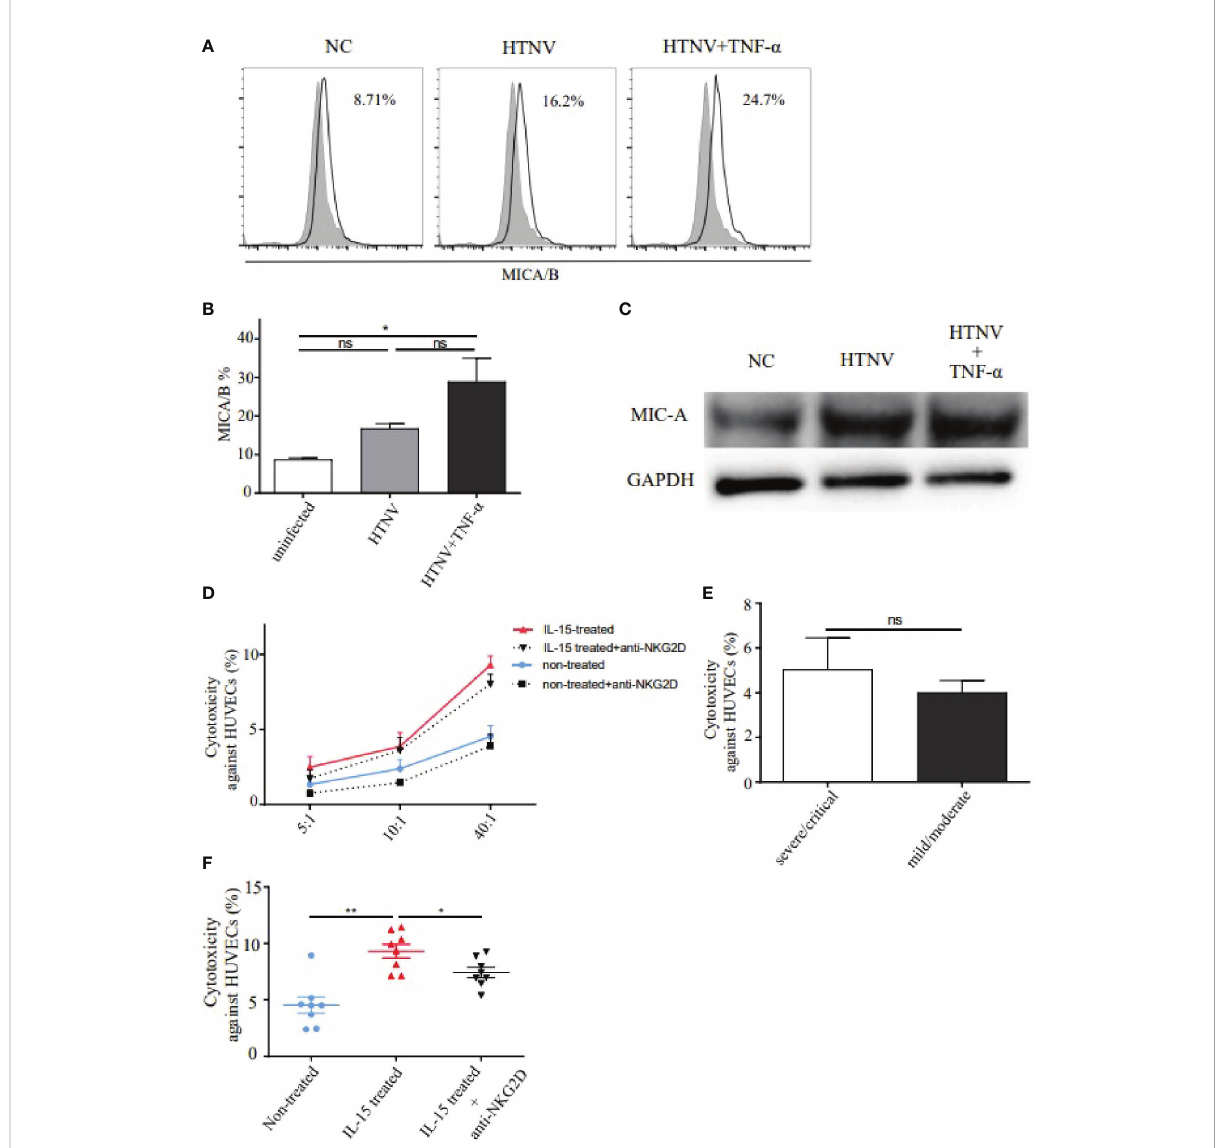
FIGURE 6 NKG2D mediated the cytotoxicity of IL-15-induced CD8 + T cells from HFRS patients against HUVECs infected with HTNV. (A, B) Representative fl ow cytometry (A) and comparison (B) of MICA/B expression on HUVECs infected with HTNV (n=3), HTNV and TNF- a (n=3), or uninfected (control) (n=3). (C) Western blot of MIC-A protein expression on HUVECs in different treatments. (D) HTNV-infected HUVECs were co-cultured with peripheral blood isolated CD8 + T cells (non-treated group, n=8), with CD8 + T cells combined with NKG2D neutralization (anti-NKG2D- blocked group, n=8), with CD8 + T cells induced by IL-15 (IL-15-treated group, n=8), and with CD8 + T cells induced by IL-15 and NKG2D neutralization (IL-15-treated with anti-NKG2D-blocked group, n=8) at (E) T ratios of 5:1, 10:1, and 40:1, respectively. (E) Comparison of the cytotoxicity of CD8 + T cells against HUVECs between the severe/critical and mild/moderate HFRS patients (both n=4) at ratios of 40:1. (F) Comparison of the cytotoxicity of CD8 + T cells against HUVECs among non-treated group (n=8), IL-15-treated group (n=8), and IL-15-treated with anti-NKG2D-blocked group (n=8). *p<0.05; **p<0.01; “ ns ” means no signi fi